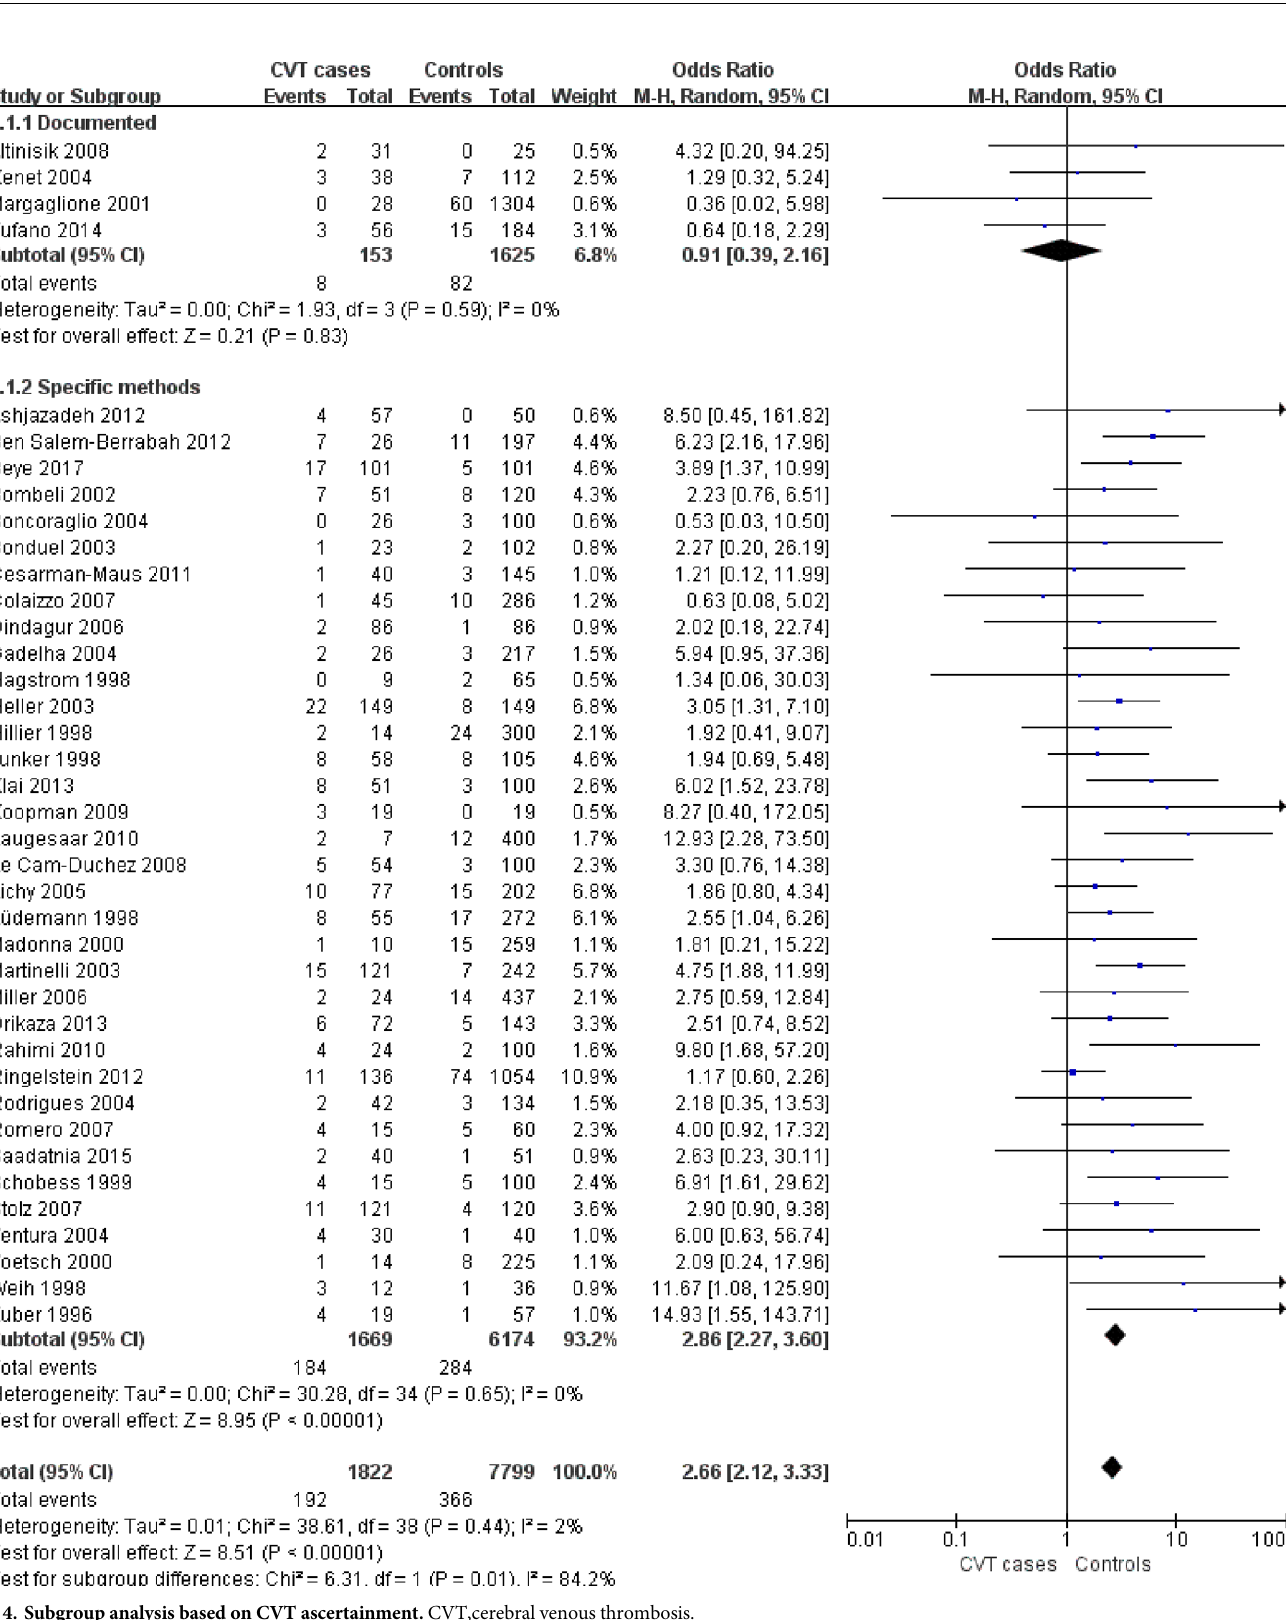
PLOS ONE | https://doi.org/10.1371/journal.pone.0203309 August 29,